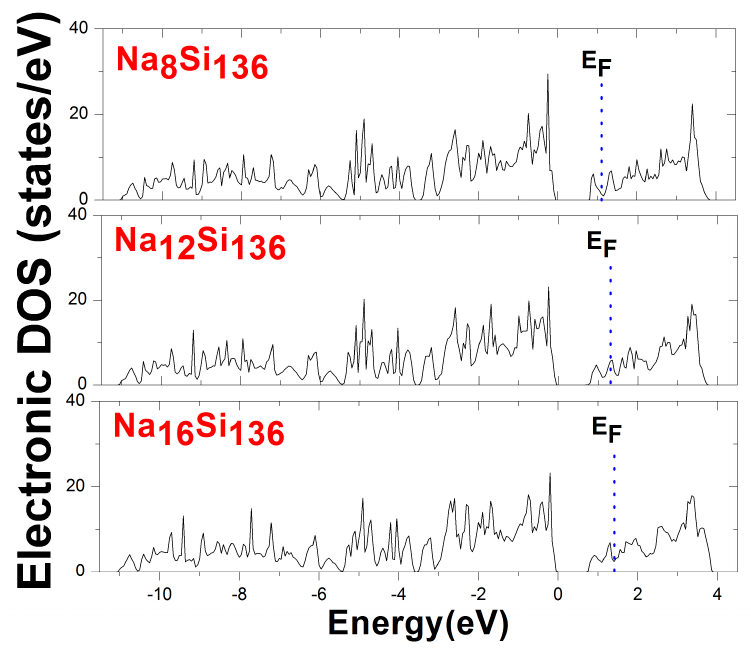
Figure 3. Electronic density of states (DOS) of the clathrate system Na x Si 136 , where x = 8, 12, 16. The Fermi energy levels ( E F ) are denoted by dotted lines.